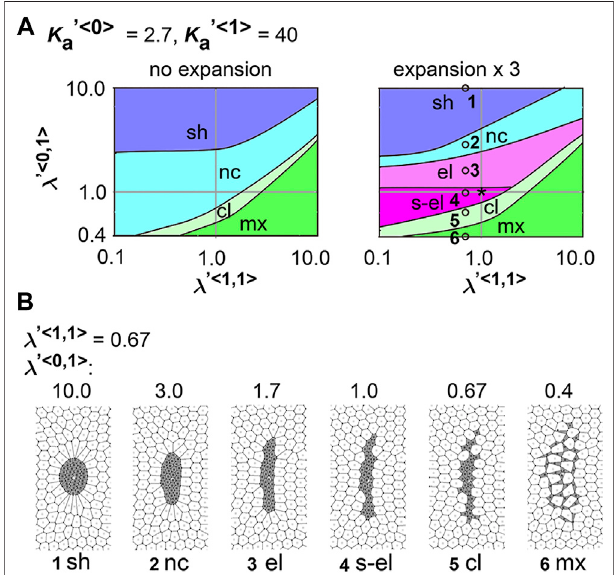
FIGURE 4 | Difference in cell – cell adhesion contributes to cell cluster elongation with differential area elasticity on expanding fi eld. Simulations were performed under conditions with various values for line tension and area elasticity,whereasthecoef fi cientoffrictionwasassignedthesamevalue for both cell types: λ < 0 , 0 > ≠ λ < 1 , 1 > ≠ λ < 0 , 1 > and K < 0 > a ≠ K < 1 > a , whereas γ < 0 > (cid:1) γ < 1 > . Phase diagrams in the absence and presence of the uniformly expanding fi eld are shown under K ′ < 0 > a (cid:1) 2 . 7 and K ′ < 1 > a (cid:1) 40 [left and right panels in (A) , respectively]. In the panel on the right, the fi elds were expanded by three times in area. Examples of simulation outcomes are shown in (B) , where the parameter values used for each condition in B are plotted on the diagram [ (A) , right panel], with the numbers corresponding to each condition (#1, #2, etc.). An asterisk on the diagram [ (A) , right panel], where Other simulation outcomes obtained with different values for the area elasticities are shown in Supplementary Figure S3 . Simulation outcomes from a different initial con fi guration are shown in Supplementary Figure S4